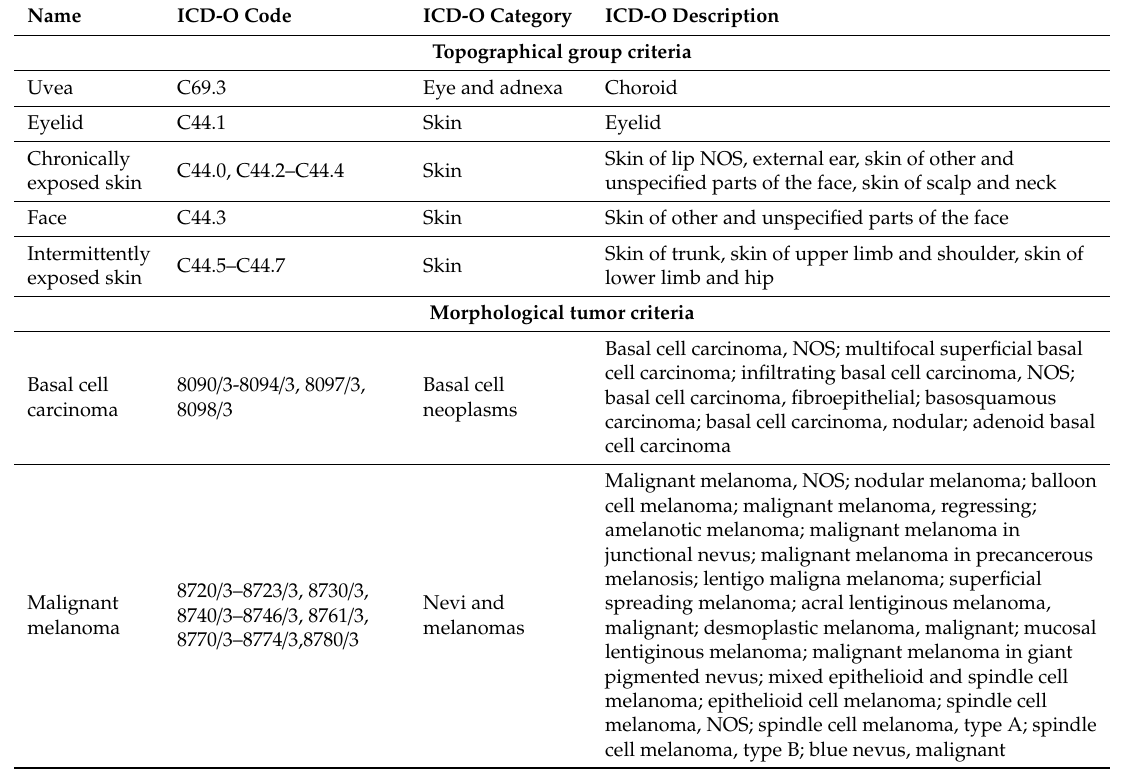
Table 4. Topographical and morphological tumor groups for data retrieval, using the International Classification of Diseases for Oncology, 3rd Edition (ICD-O-3) histologic